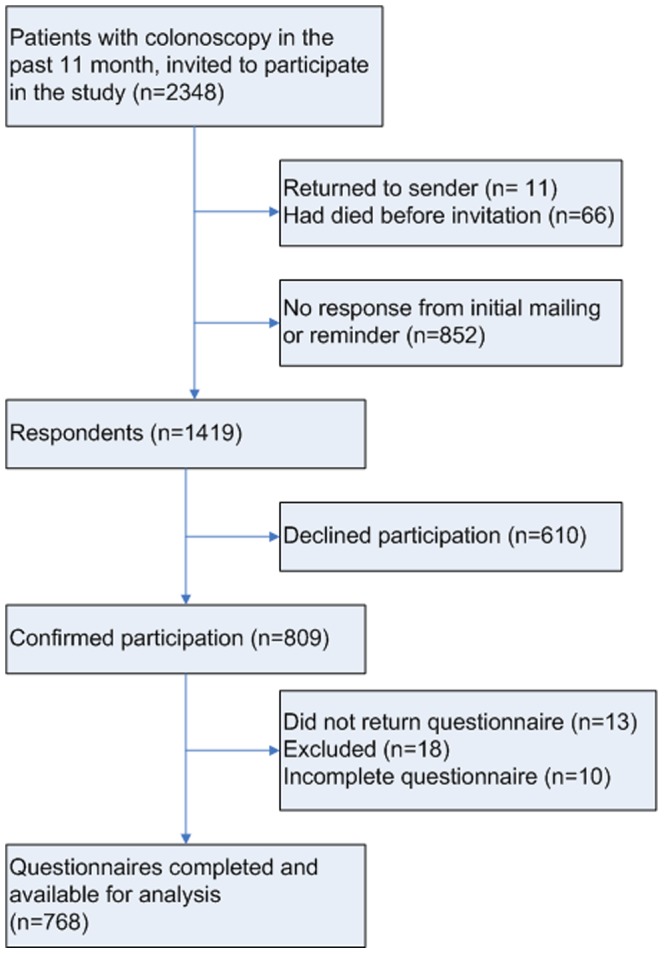
Study flow diagram.